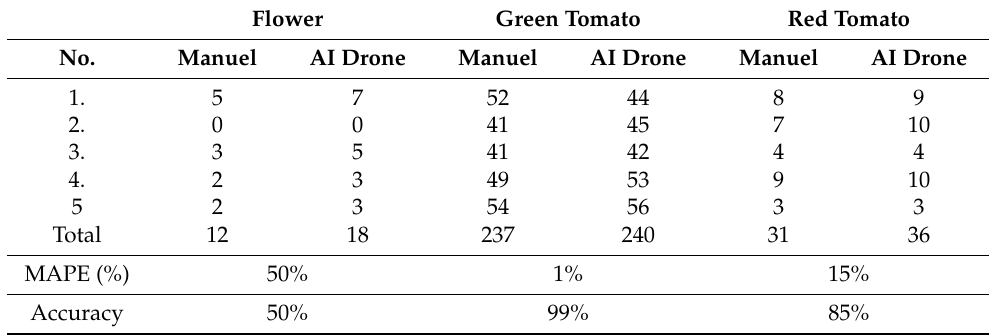
Table 3. Detection and Counting Results.